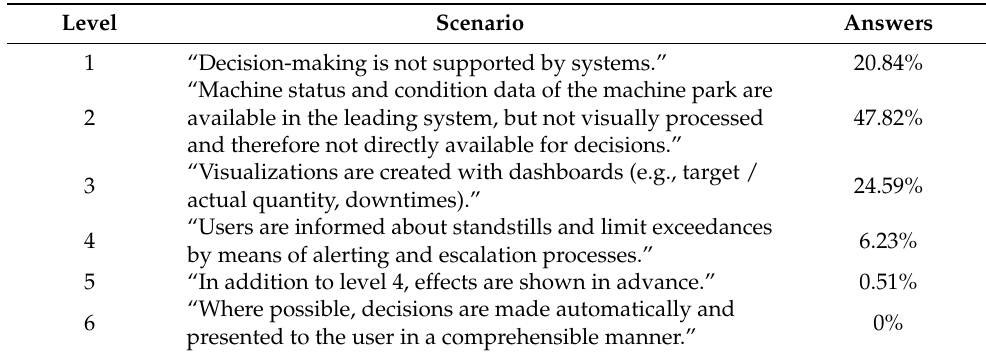
Table 2. Results for the capability “decision support